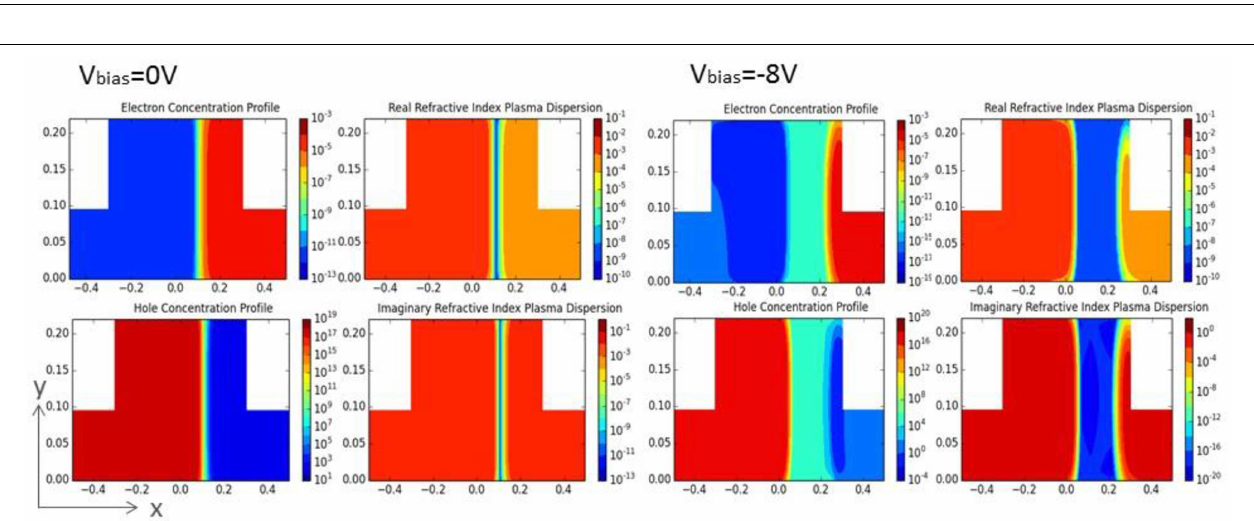
FIGURE 3 | Contour plots of non-uniform carrier concentration and it equivalent complex refractive indices for mod2 mod1 at 0V and − 8V.